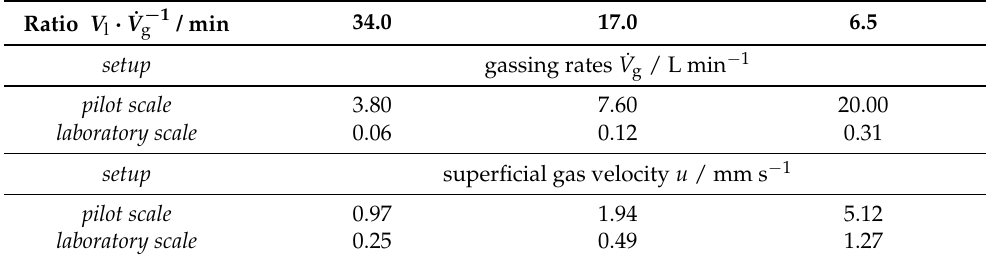
Table 2. Specific gassing rates ˙ V g for experiments in the two